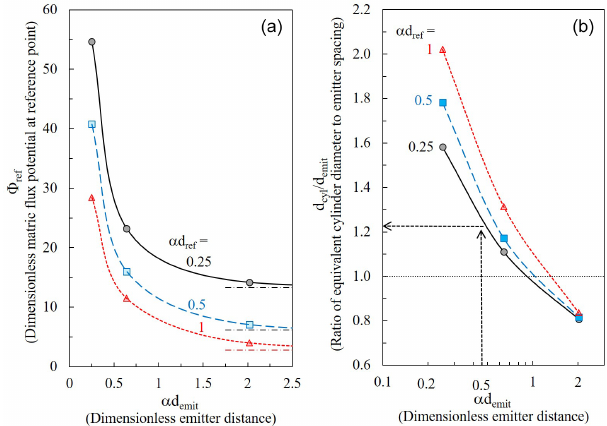
Figure 8. (a) Non-dimensional matric flux potential ( (cid:56) ref ) and (b) the ratio between the equivalent cylindrical base diameter ( d cyl ) and the emitter spacing ( d emit ), as a function of the non-dimensional distance between emitters ( αd emit ), for different non-dimensional depths ( αd ref ) below the emitter. The dash–dotted lines in (a) rep- resent (cid:56) ref at the given depth below a single emitter. (cid:56) ref = 8 πφ ref /αq , α is the soils capillary lengths, q is the emitter discharge